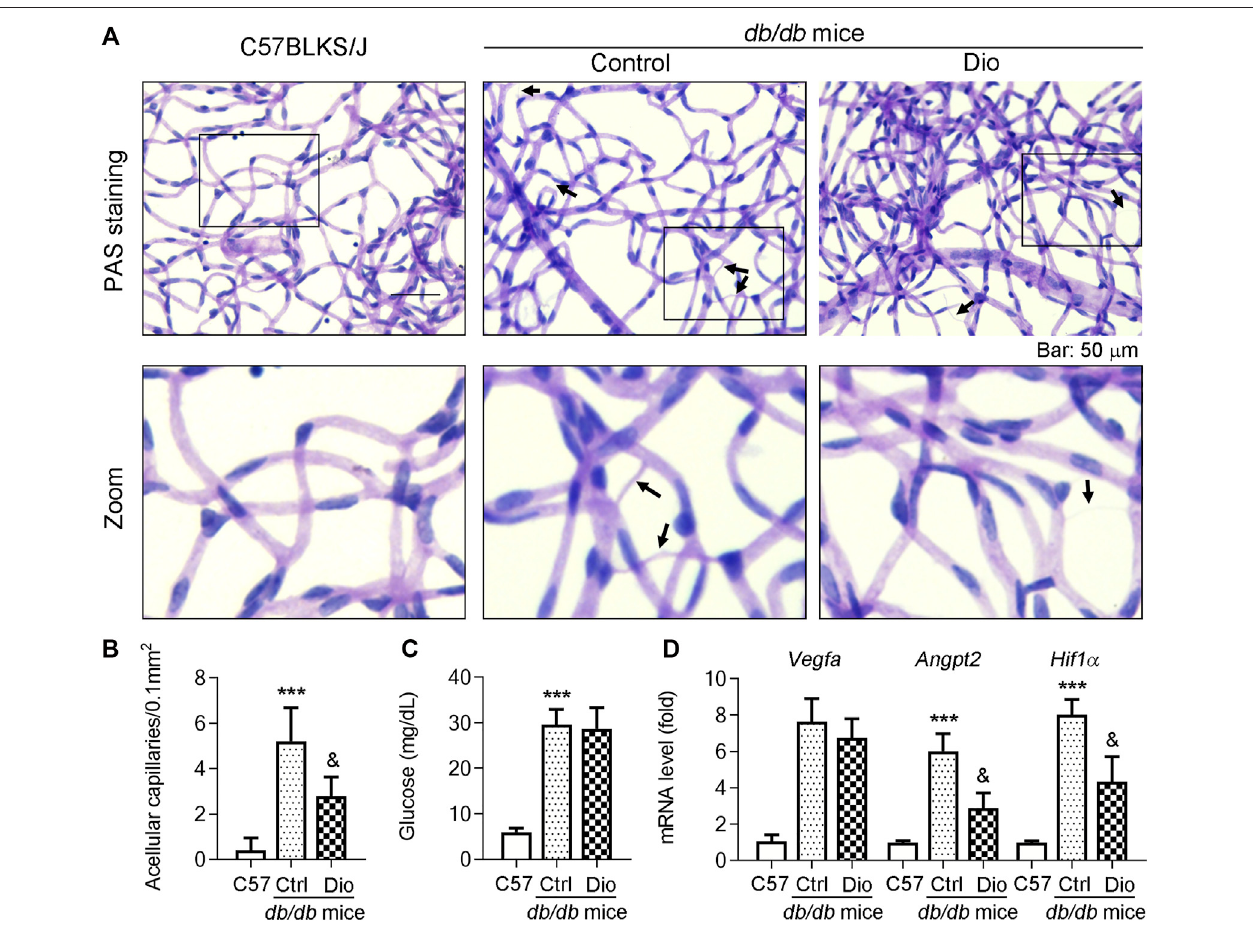
FIGURE6| Oraladministrationofdioscininhibitsvasculardamageintheretinaof db/db mice.The db/db micewereadministratedwith80mpkofdioscindailyfrom 8weeksofageto24 weeksofage. (A) Attheendofthestudy,mouseeyeswerecollectedandtheretinalvascularnetworkwasprepared,followedbyPASstaining.The representative images from each group are presented. Black arrows indicate acellular capillaries in the retinal vasculature. Bars: 50 μ m. (B) Quantitation of acellular capillaries in the retina. (C) At the end of study, mice were starved for 16 h and blood samples were collected and the glucose levels were determined, n (cid:1) 5. (D) Vegfa , Angpt2, and Hif1 α mRNA expression in the retinas was determined by qPCR analysis, n (cid:1) 5. *** p < 0.001 vs. C57BLKS/J mice and & p < 0.05 vs. db/db mice by one-way ANOVA with Bonferroni correction.